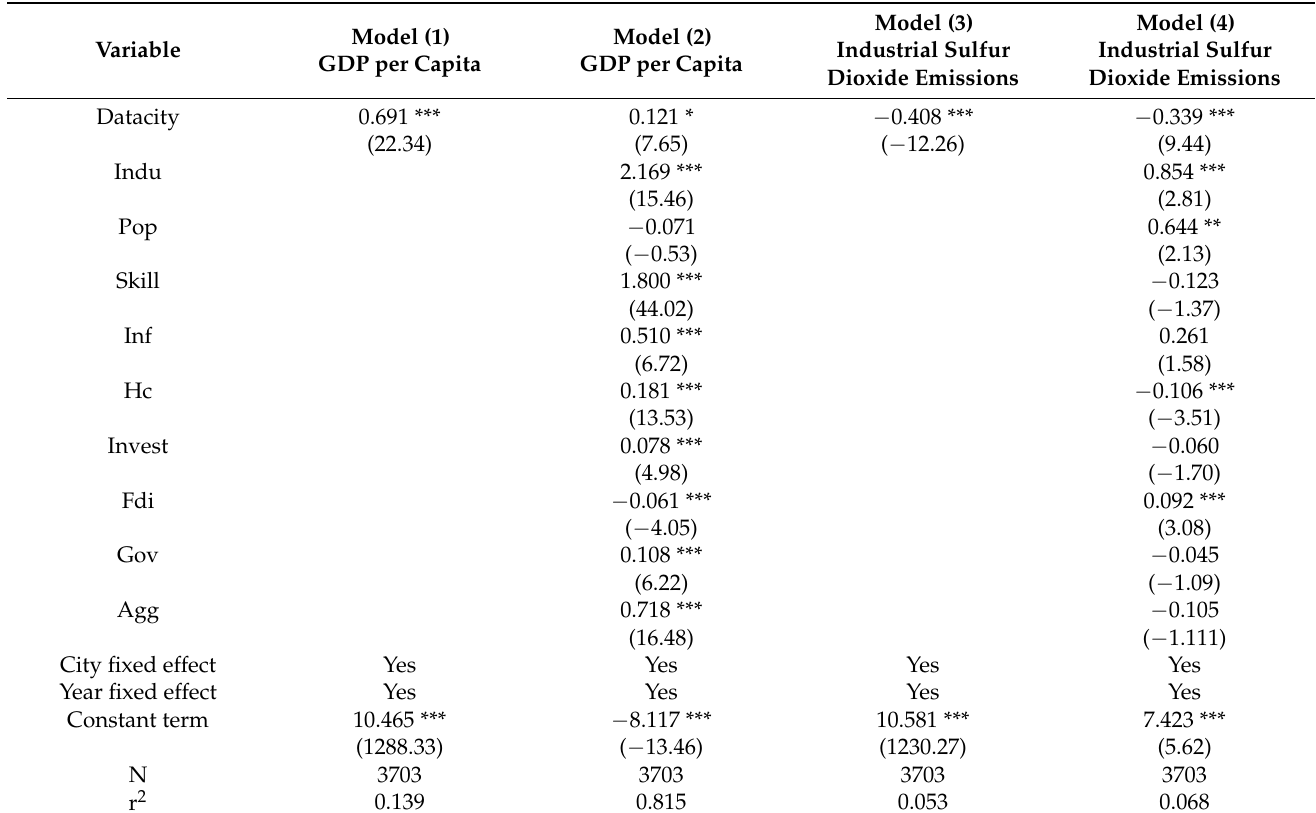
Table 2. Estimation results of the impact of sponge city construction on economic development and environmental pollution